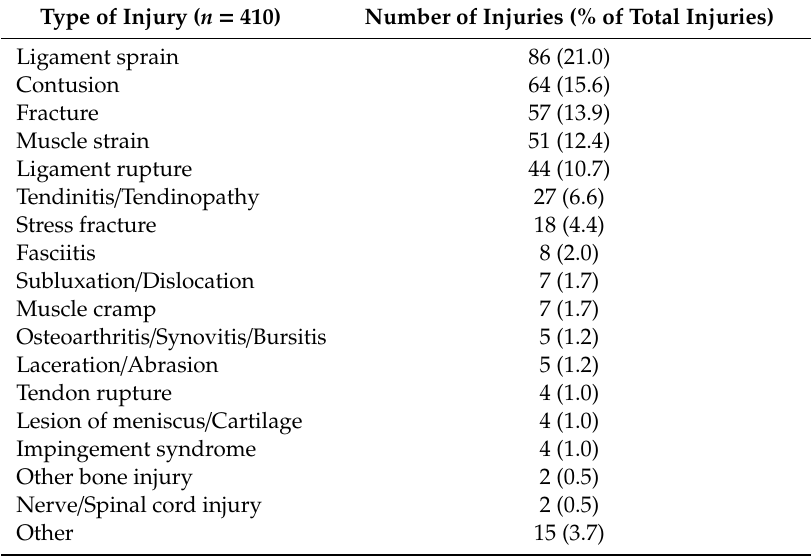
Table 5. Types of injury in U-15 youth soccer during the 2019 season.